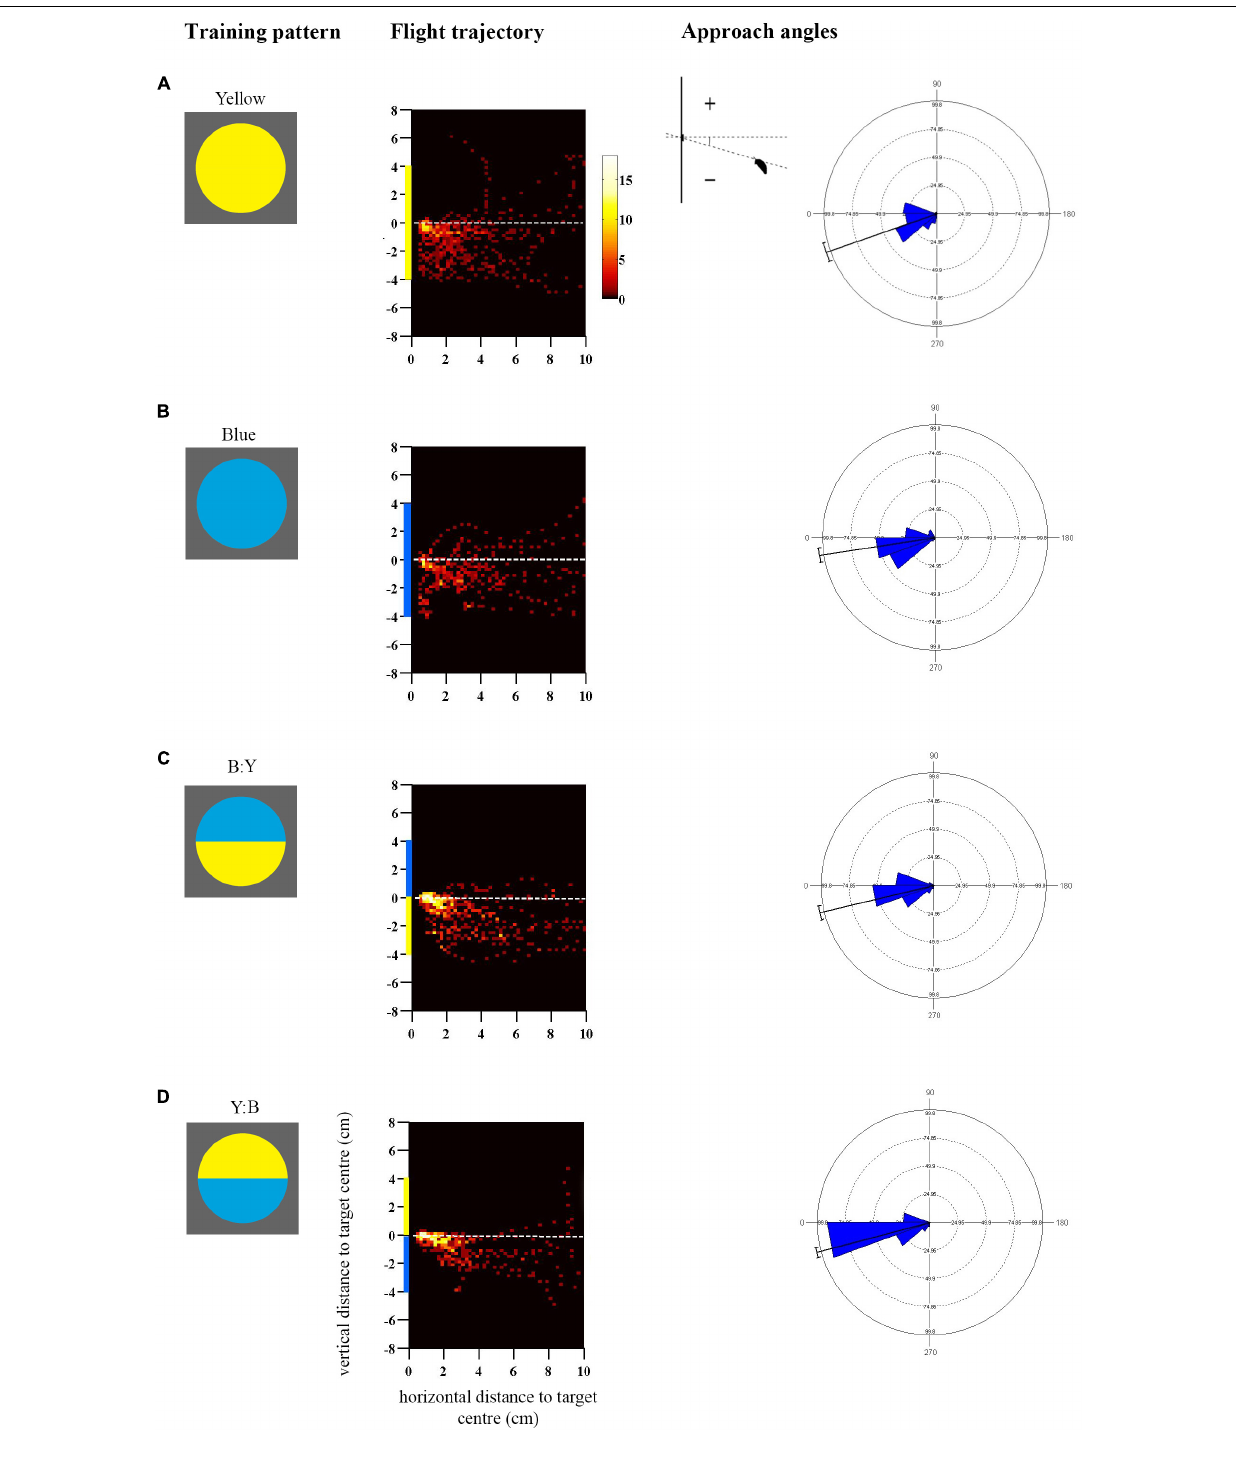
Frontiers in Physiology |